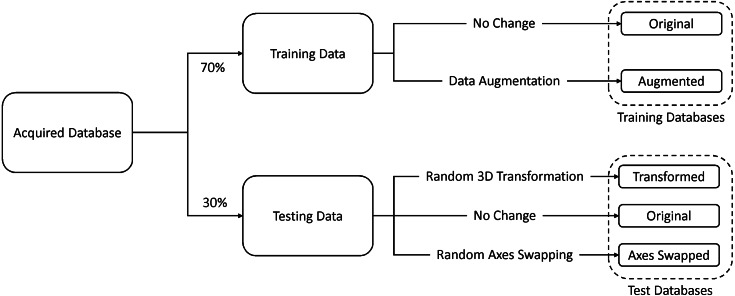
Database formation.